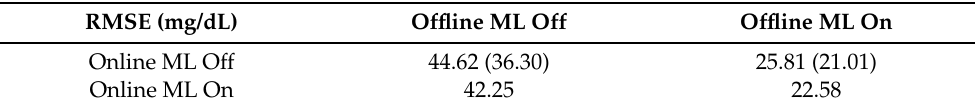
Table 1. The summary of results for the BGL prediction task with the stationary target profile (adult#001). Numbers in the brackets are from the model without the sliding window, and the others are with the sliding window (length = 576). ML denotes meta-learning. RMSE (mg/dL) Offline ML Off Offline ML On Online ML Off